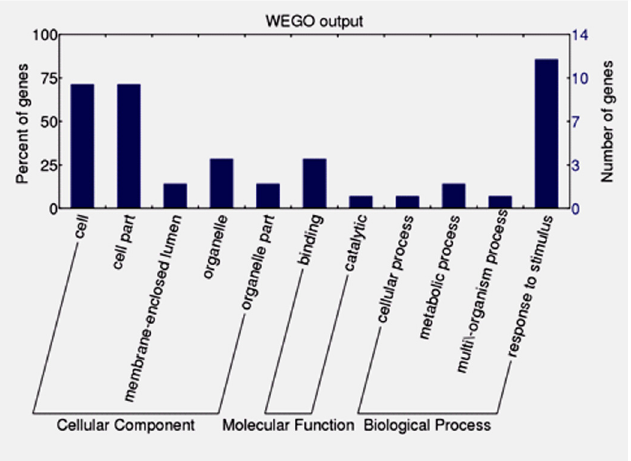
Fig 10. GO function classification of the identified genes expressed specifically or preferentially in the crossed ovules of Xanthoceras sorbifolium